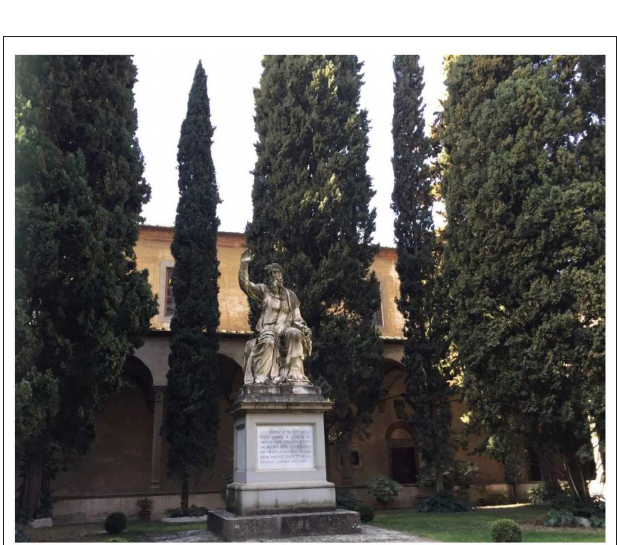
FIGURE 5 | Cypress trees surrounding the monument to the fallen soldiers of World War I in the cloister of the Franciscan Basilica di Santa Croce (the Basilica of the Holy Cross) in Florence. Each tree is dedicated to one fallen soldier (in this case to Gold Medallists), according to the concept of “Park of Remembrance.” Picture by S.